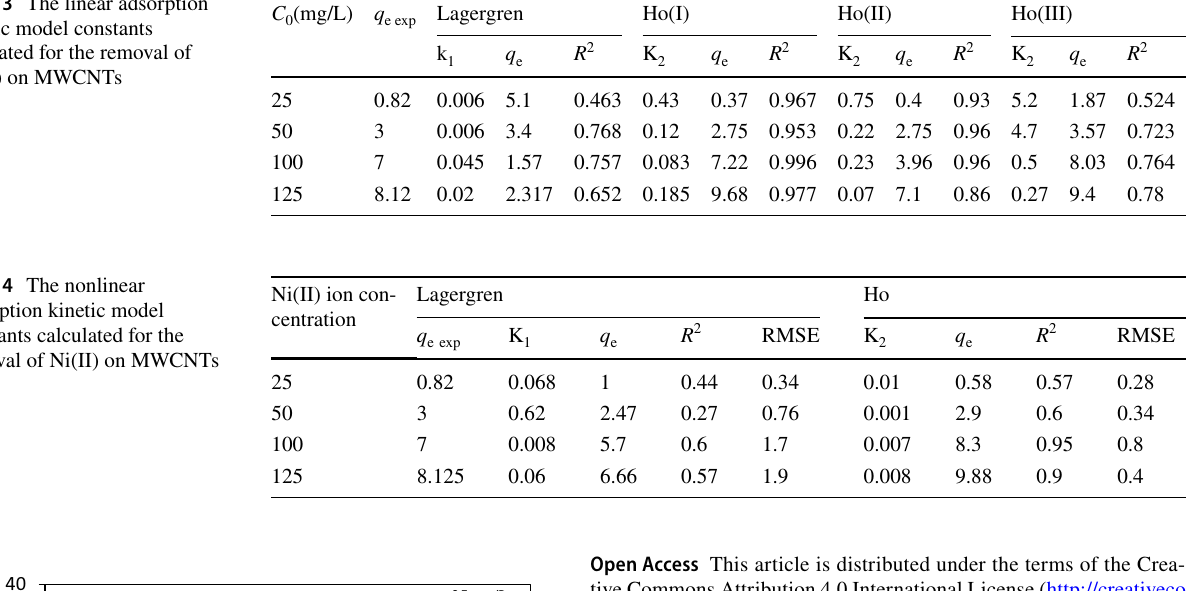
Table 3 The linear adsorption kinetic model constants estimated for the removal of Ni(II) on MWCNTs